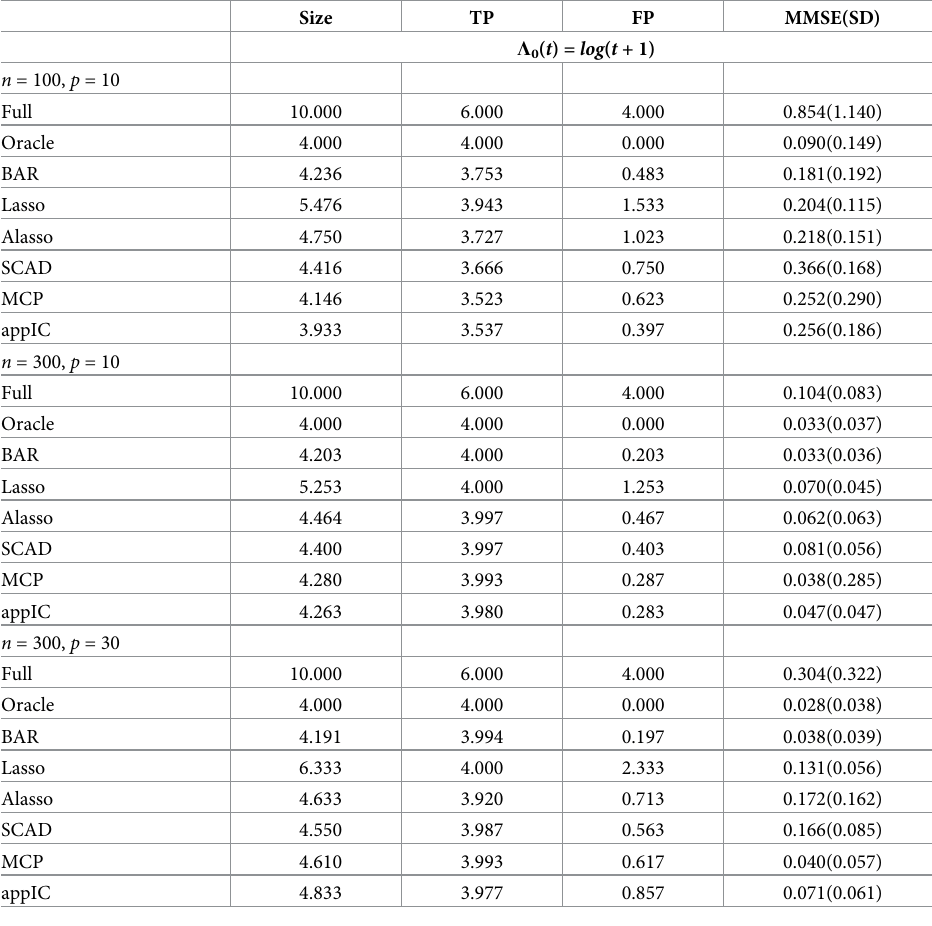
Table 7. Estimation results with different